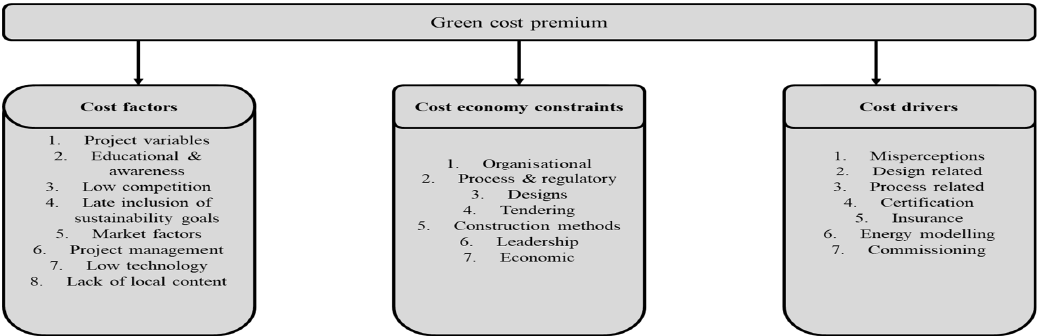
Fig. 5. Summary of practice contexts to high costs of sustainable